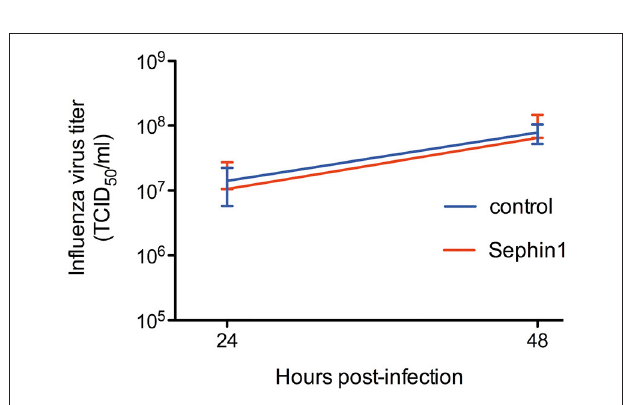
FIGURE 6 | Evaluation of the antiviral properties of Sephin1 against Japanese encephalitis virus. HEK293T cells were infected with Japanese encephalitis virus and incubated in the presence of 50 µ M Sephin1 or DMSO alone (control). Viral titers were determined by quantitative RT-PCR from supernatants harvested at the indicated times post-infection. Data represent mean ± SEM from a representative experiment, repeated at least three